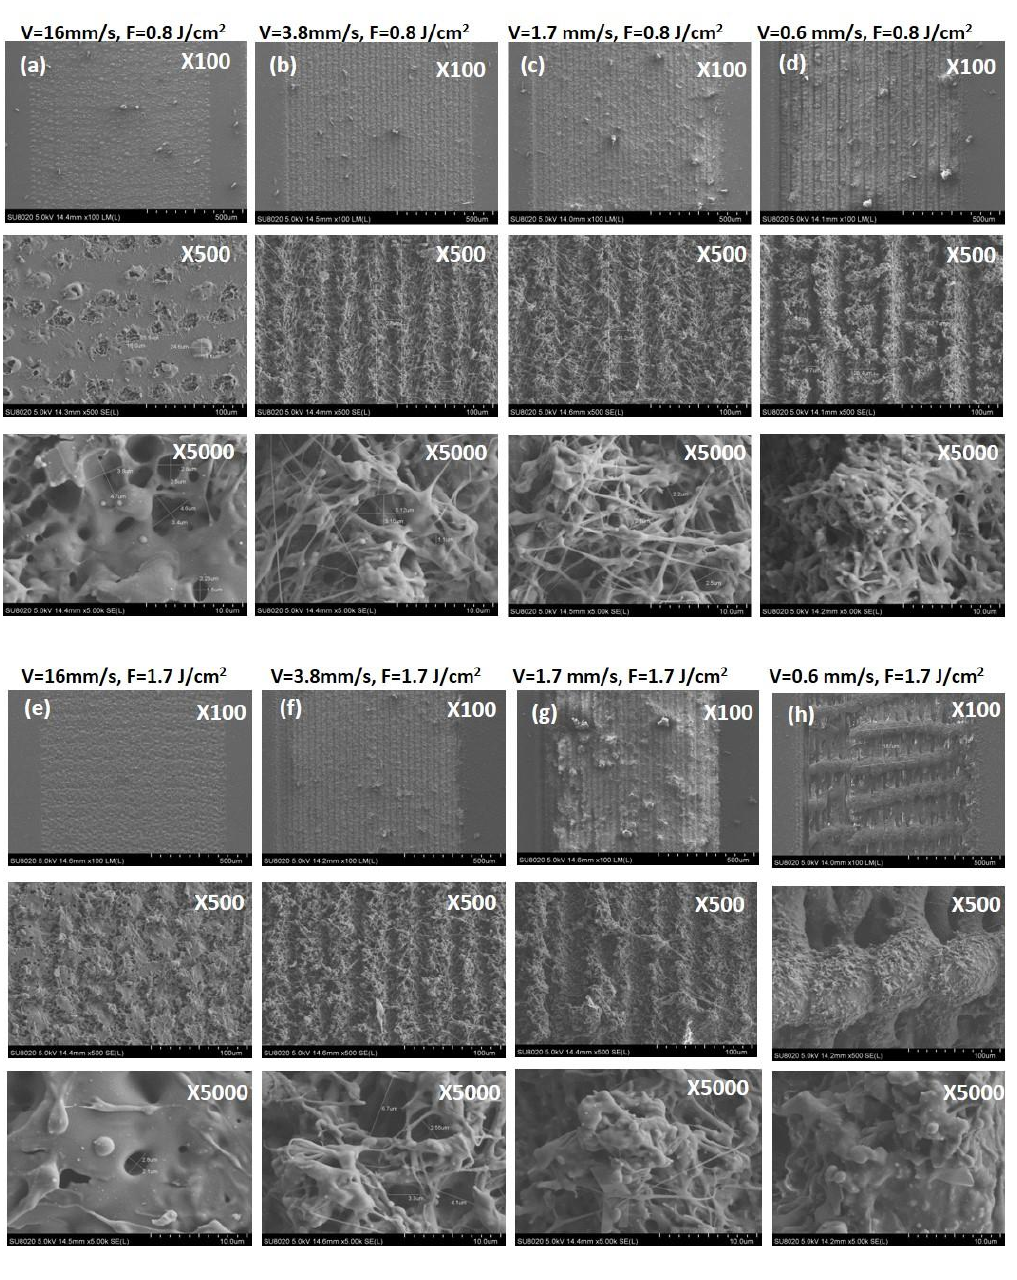
Figure 6. SEM images of PLA matrices: ( a – d ) patterned with F = 0.8 J/cm 2 and V = 16, 3.8, 1.7, 0.6 mm/s, respectively ( e – h ) and F = 1.7 J/cm 2 and V = 16, 3.8, 1.7, 0.6 mm/s